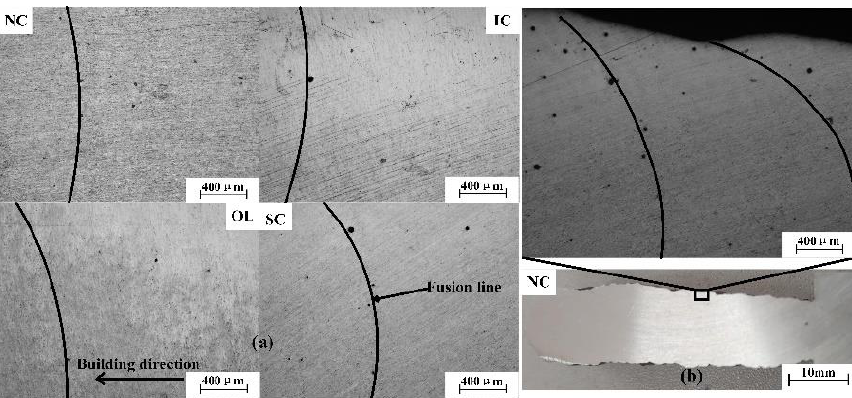
Figure 9. Defects in macroscopic morphology: ( a ) the pores near the fusion line; ( b ) pores at the edge of the wall deposited by the natural cooling (NC) process.